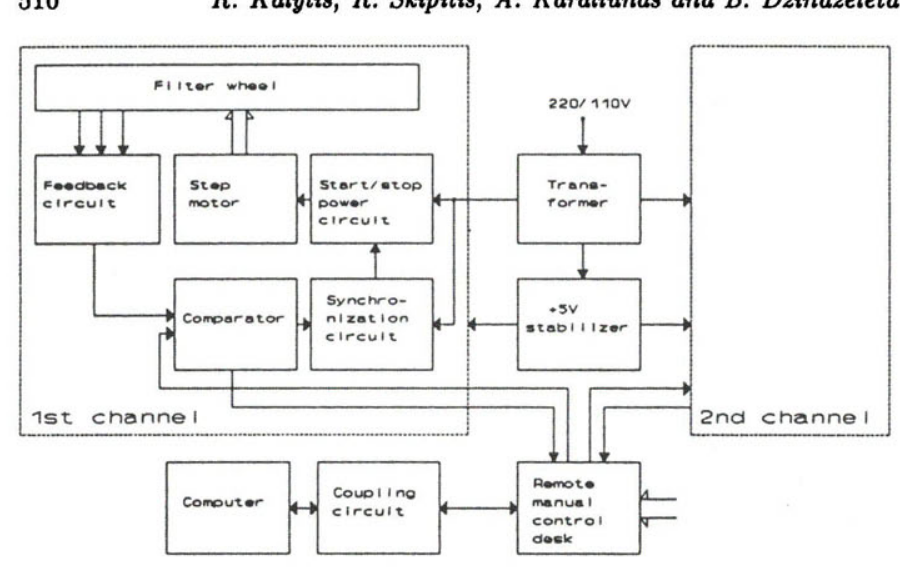
Fig. 2. The block-diagram of the filter setting system